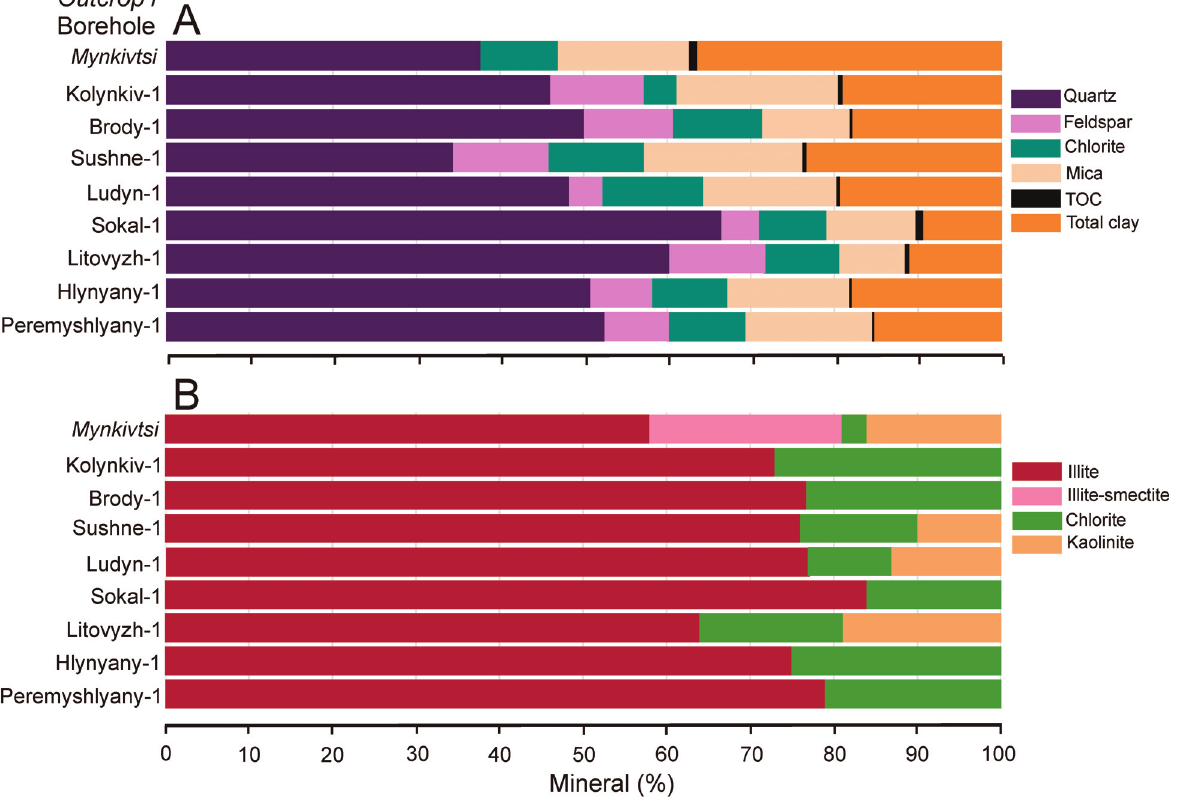
Fig. 6. Mineralogy of the Ediacaran Kalus rocks. A , whole-rock samples. B , clay fraction samples. TOC content data after Radkovets et al.